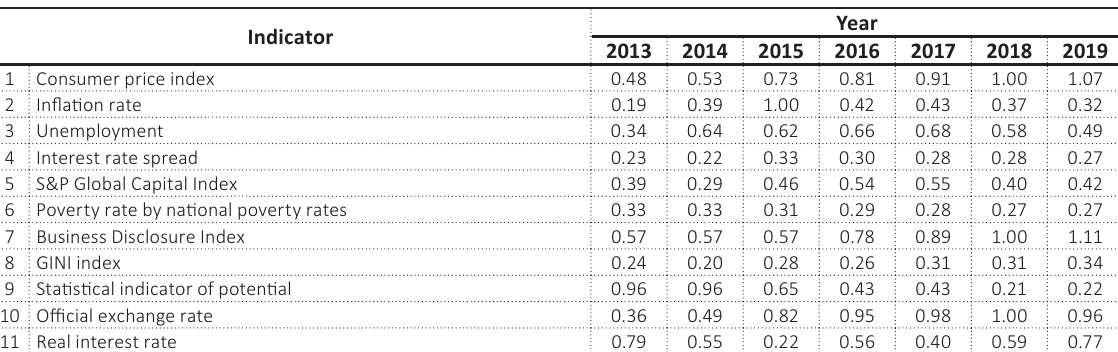
Table 6. Normalized indirect impact indicators in the context of assessing Ukraine’s financial